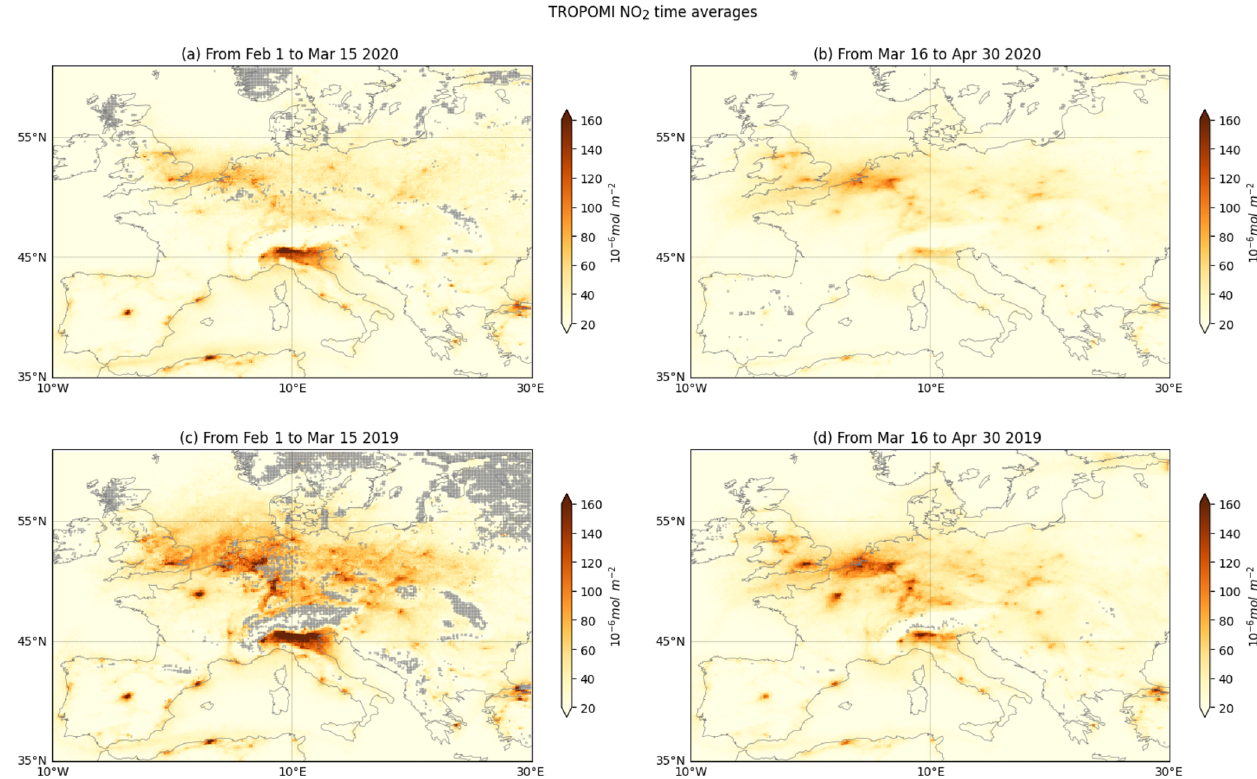
Figure 1. Average maps of the TROPOMI NO 2 tropospheric columns (molm − 2 ) for European pre-lockdown and lockdown periods in 2020 (a, b) and corresponding periods in 2019 (c, d) . Grey areas indicate where the number of revisits is strictly below